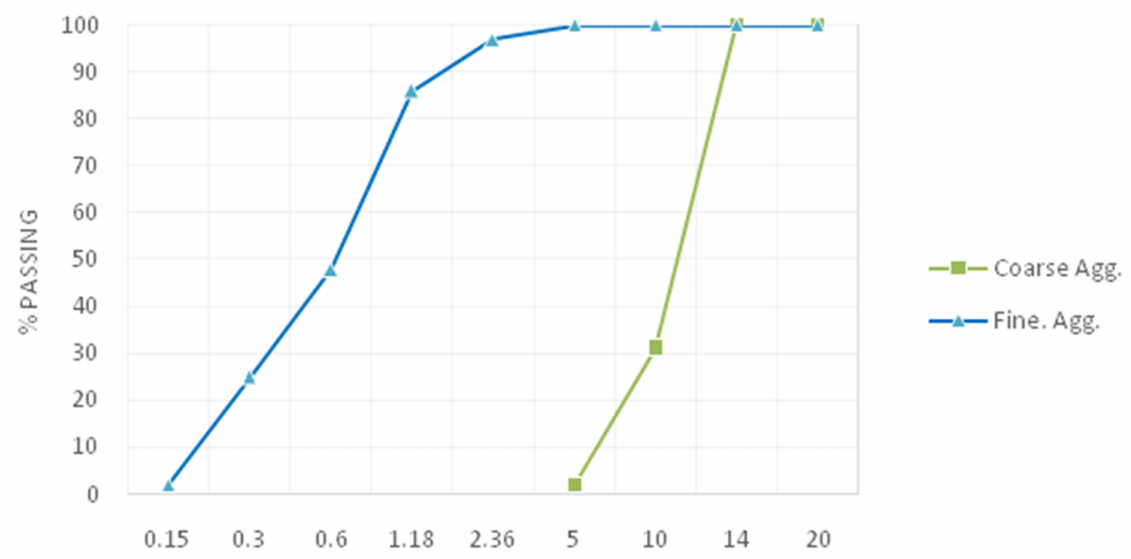
Figure 1. Grading of fine and coarse aggregates. Sieve size, mm.